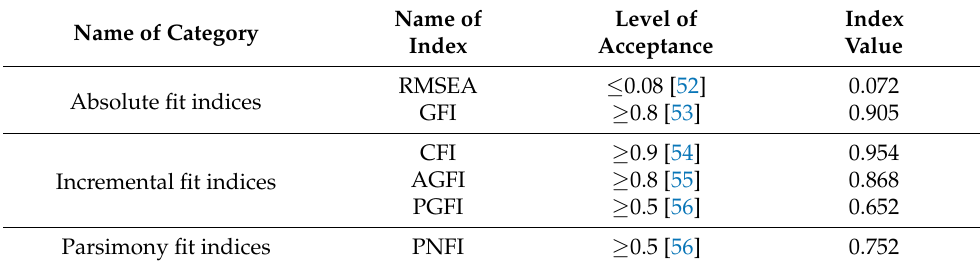
Table 4. The results for the goodness of fit